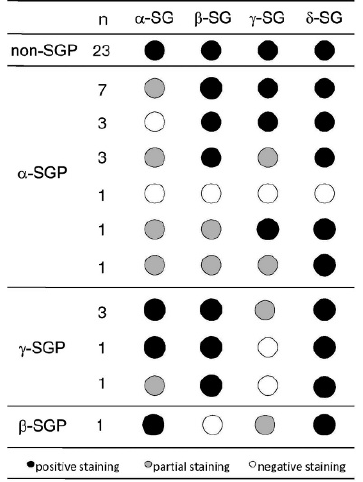
Figure 1 - Patterns of immunohistochemical findings in the non- SGP, a -SGP, c -SGP, and b -SGP groups. Non-SGP: positive staining for all four of the sarcoglycans; a -SGP: a -sarcoglycanopathy; c - SGP: c -sarcoglycanopathy; b -SGP: b